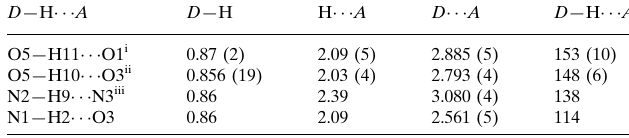
Hydrogen-bond geometry (A˚ , (cid:4)